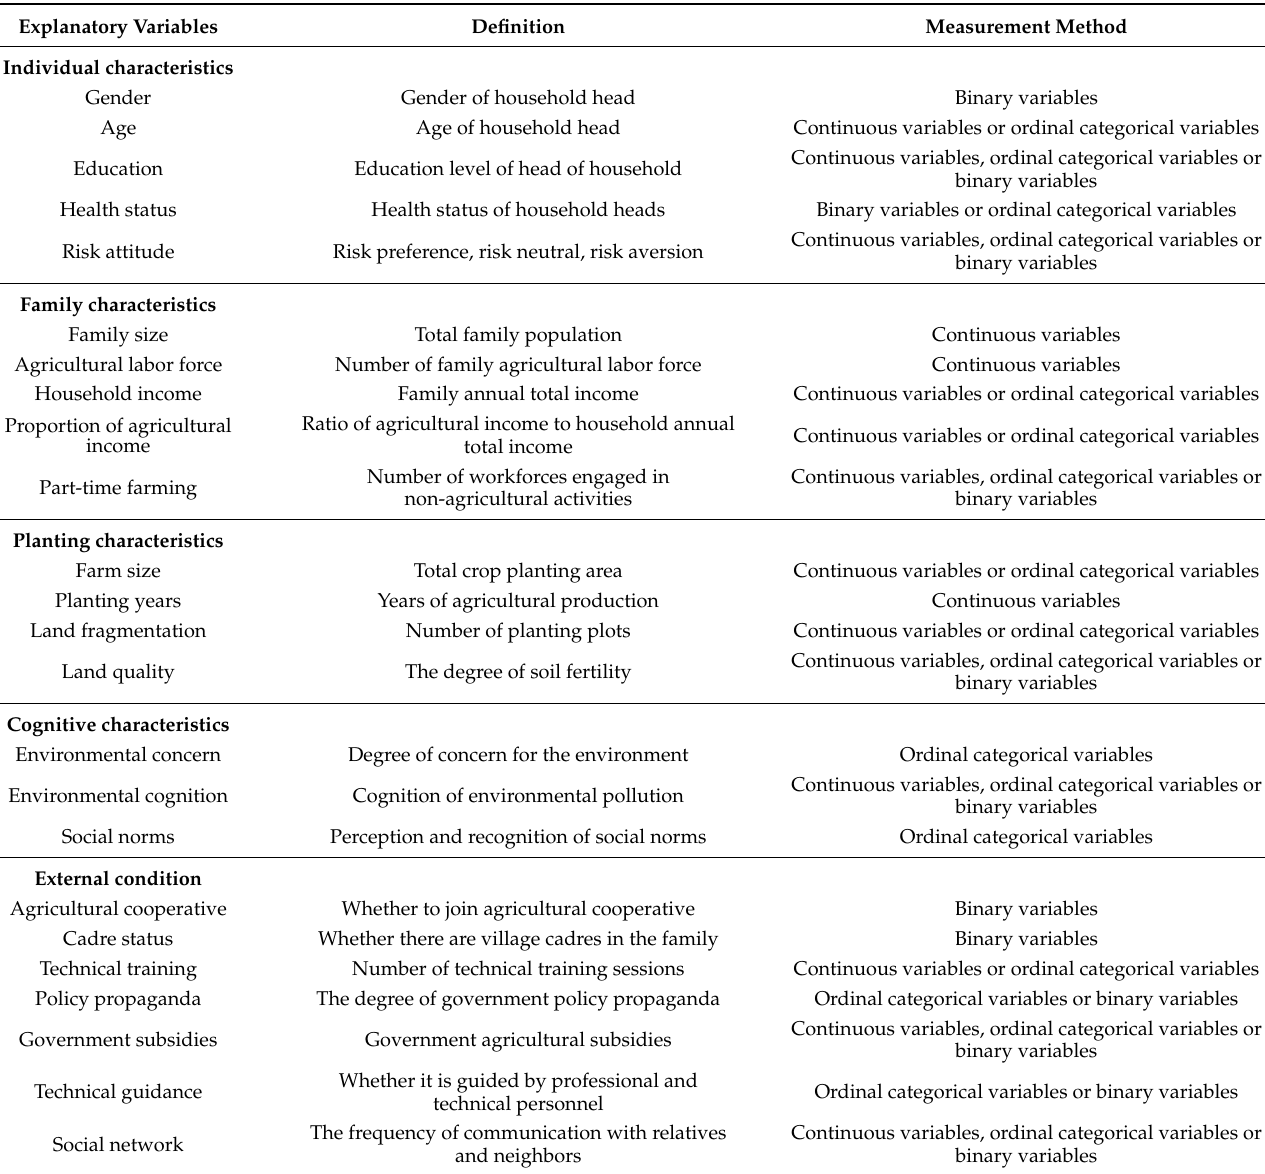
Table 1. Explanatory variables and measurement